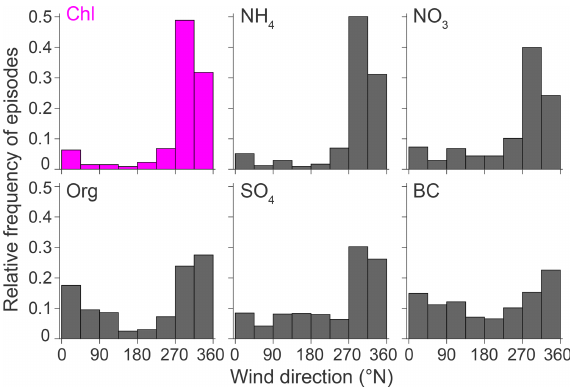
Figure 8. Relative frequency for high episodic concentrations of PM 1 species (concentrations greater than the 90th percentile con- centration of that species for the entire campaign) as a function of the wind direction.